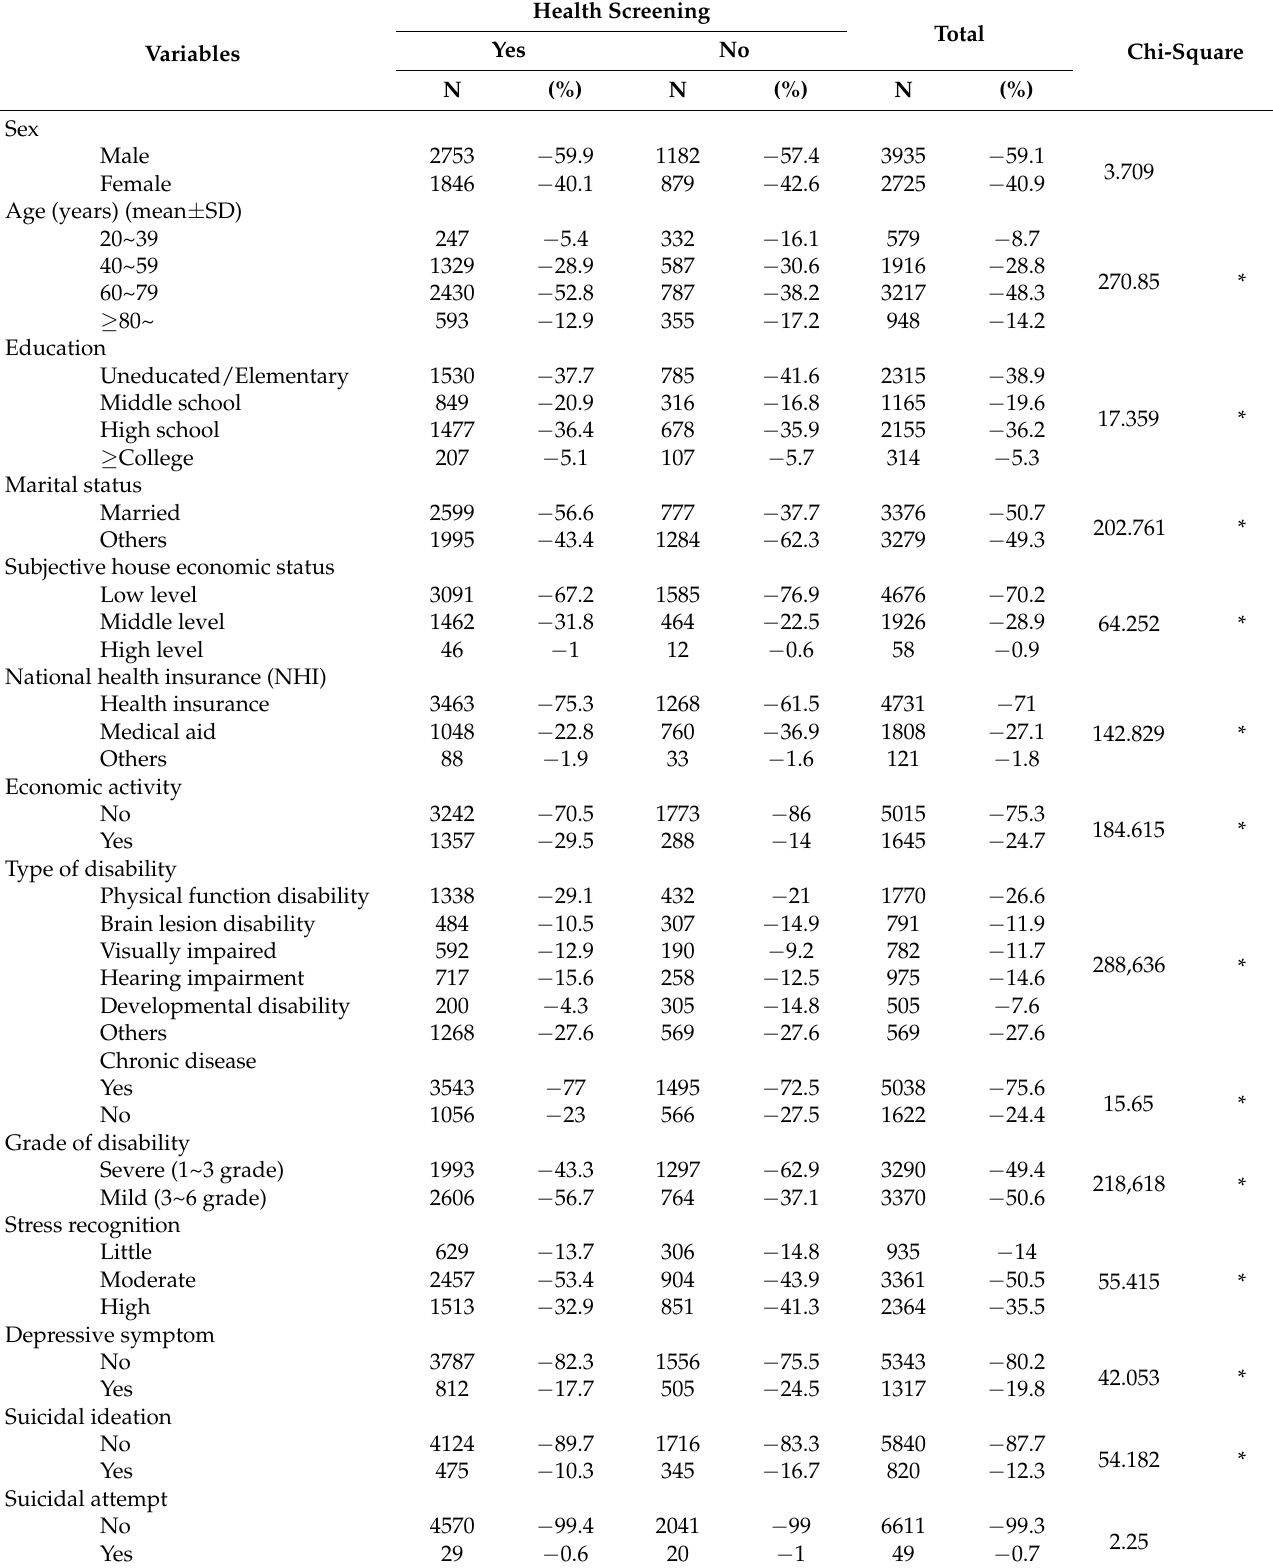
Table 3. Comparison of factors according to participation and non-participation in health screening experiences (N =